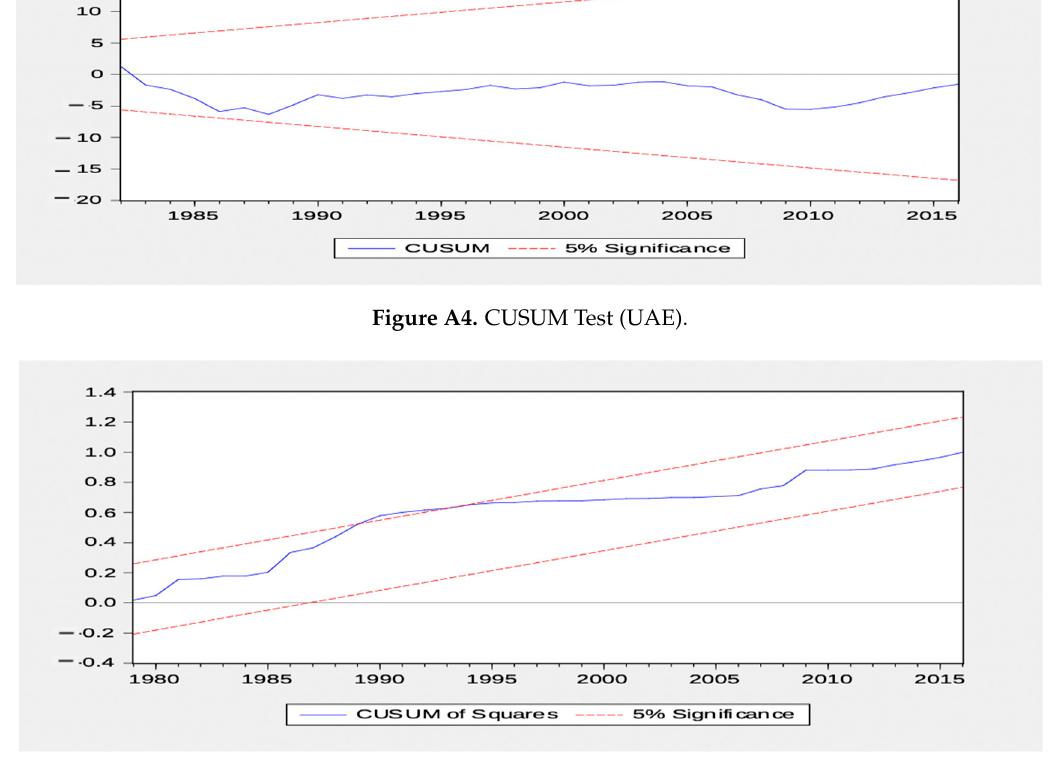
Figure A5. Square of CUSUM Test (UAE).